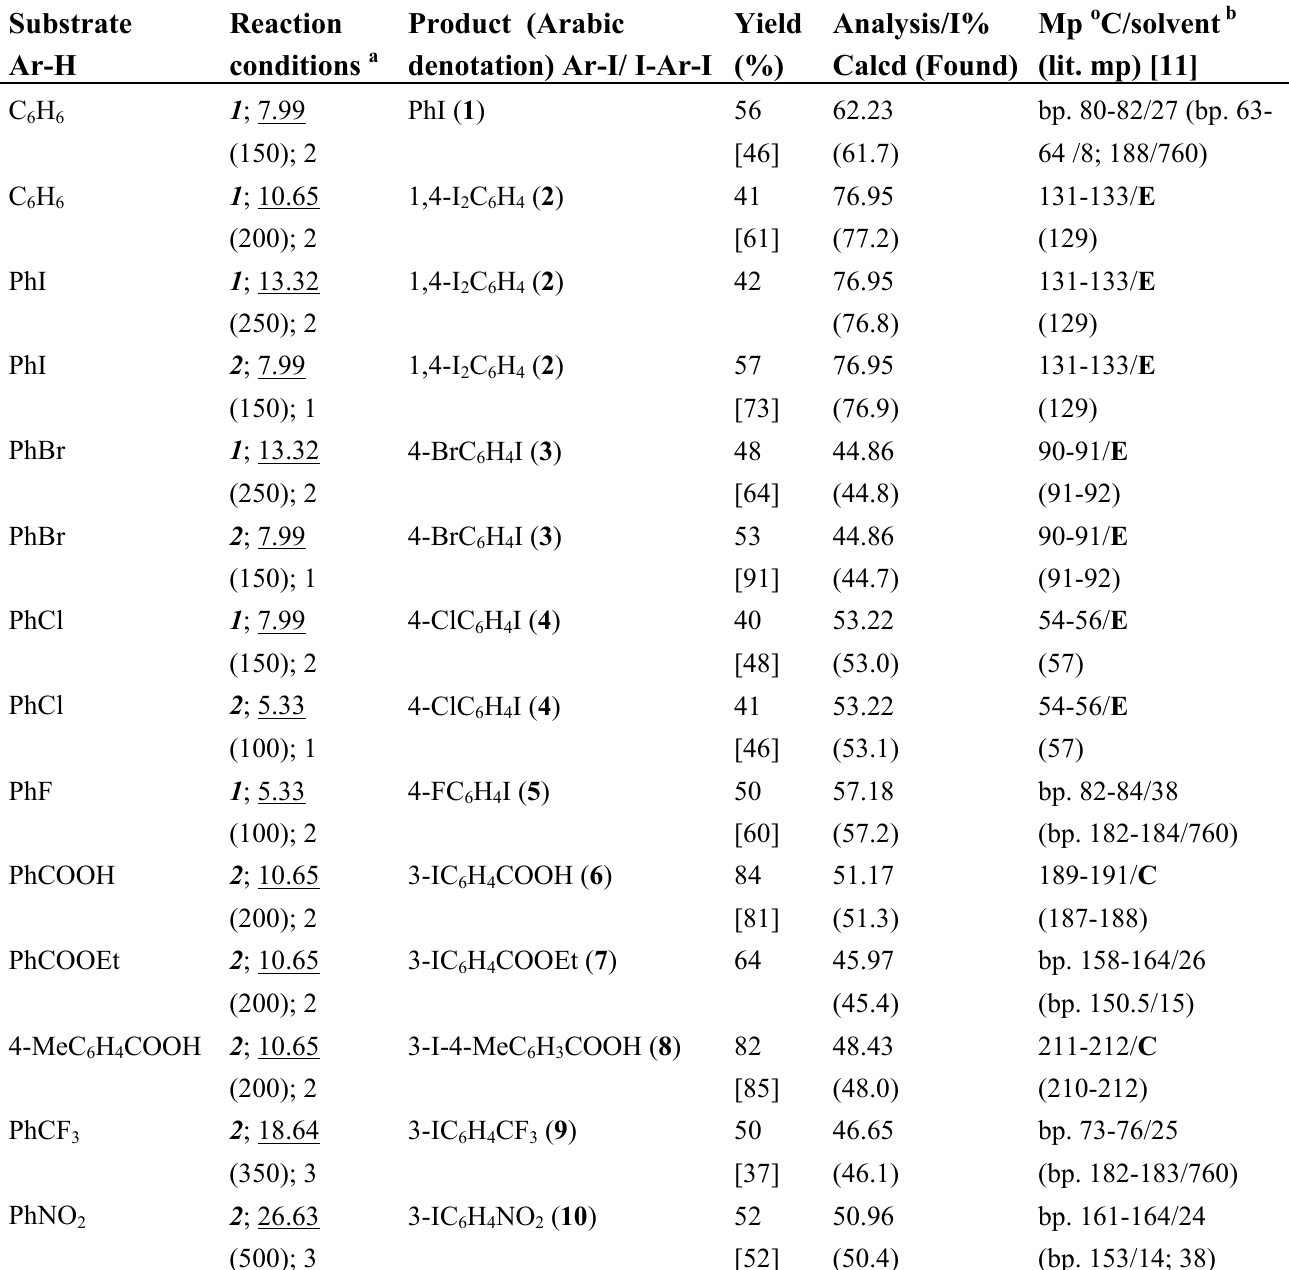
Table. Iodinated pure products